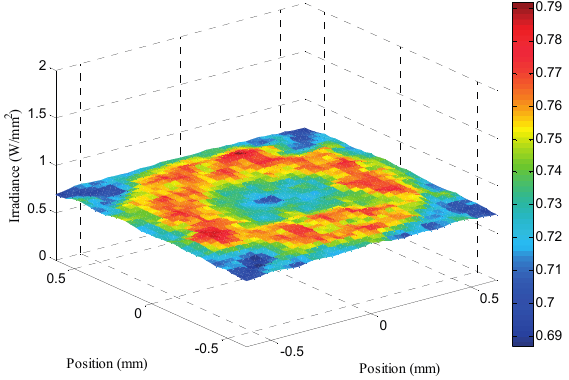
Figure 7. Irradiance distribution on the receiver under normal incidence for the Fresnel lens with KFTS-type SOE.